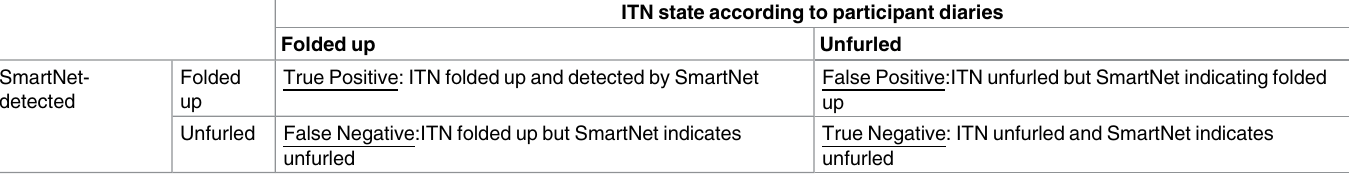
Table 1. Accuracyof SmartNetin determining ITN